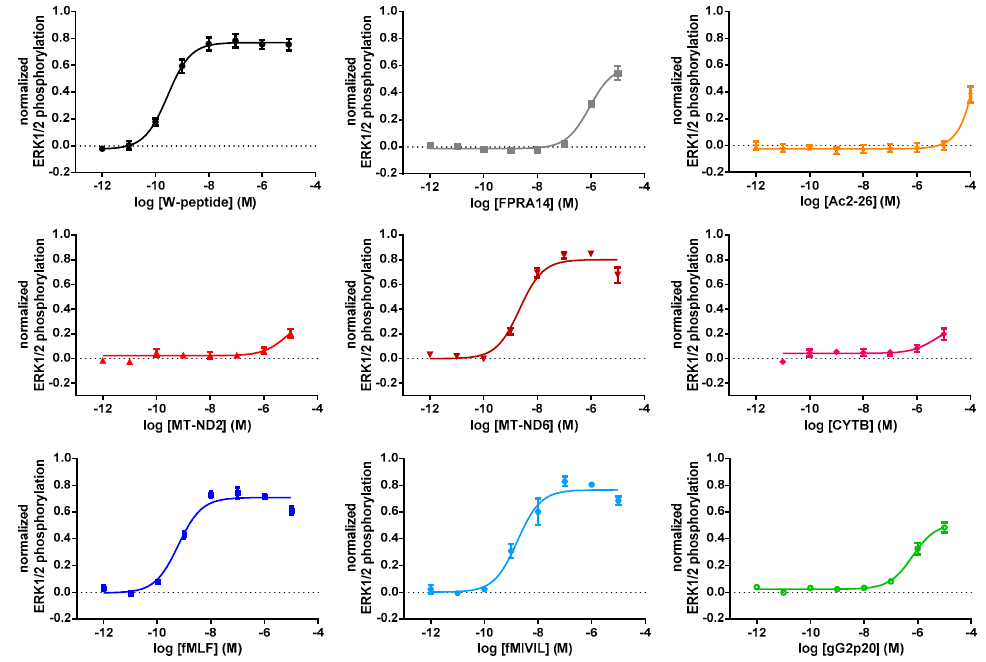
Figure 3. Concentration–response curves for FPR1-mediated phosphorylation of ERK1/2 on Thr202/Tyr204. Responses monitored 5 min after the addition of agonist were normalized to the maximum system response, which was obtained with PMA (phorbol 12-myristate 13-acetate). Data points represent the mean ± SEM of at least 5 independent